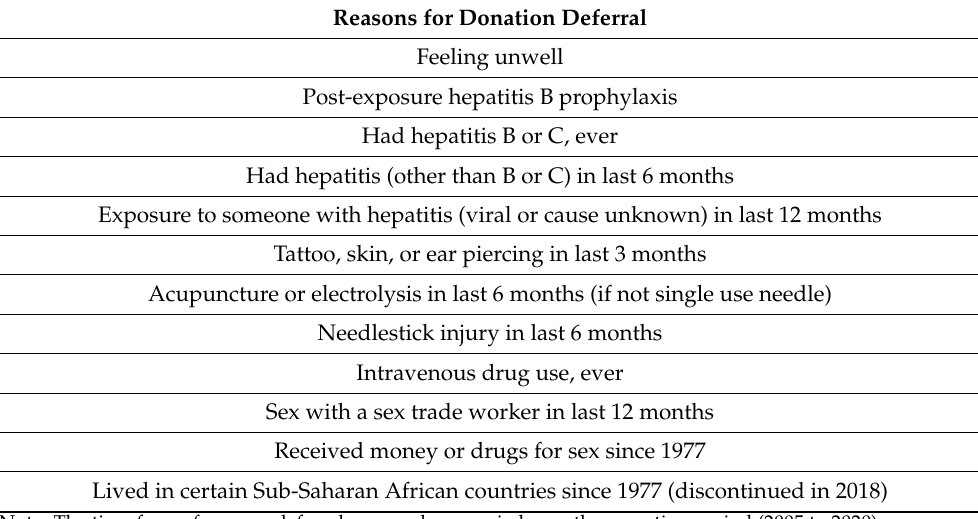
Table 2. Reasons a donor may be deferred from donating blood based on pre-donation screening questions related to HBV sexual or percutaneous risk